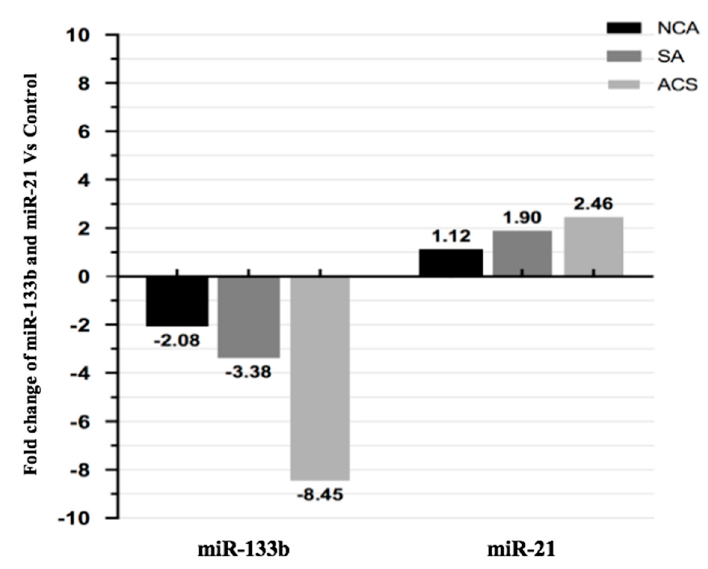
Figure 3. Relative fold changes of miR-133b and miR-21 in different categories of CAD compared to healthy controls. MiR-133b was downregulated by 8.45 fold in ACS, 3.38 fold in SA and 2.08 fold in NCA category patients as compared to healthy subjects. MiR-21 was upregulated by 2.46 fold in ACS, 1.90 fold in SA and 1.12 fold in NCA category patients as compared to healthy subjects.